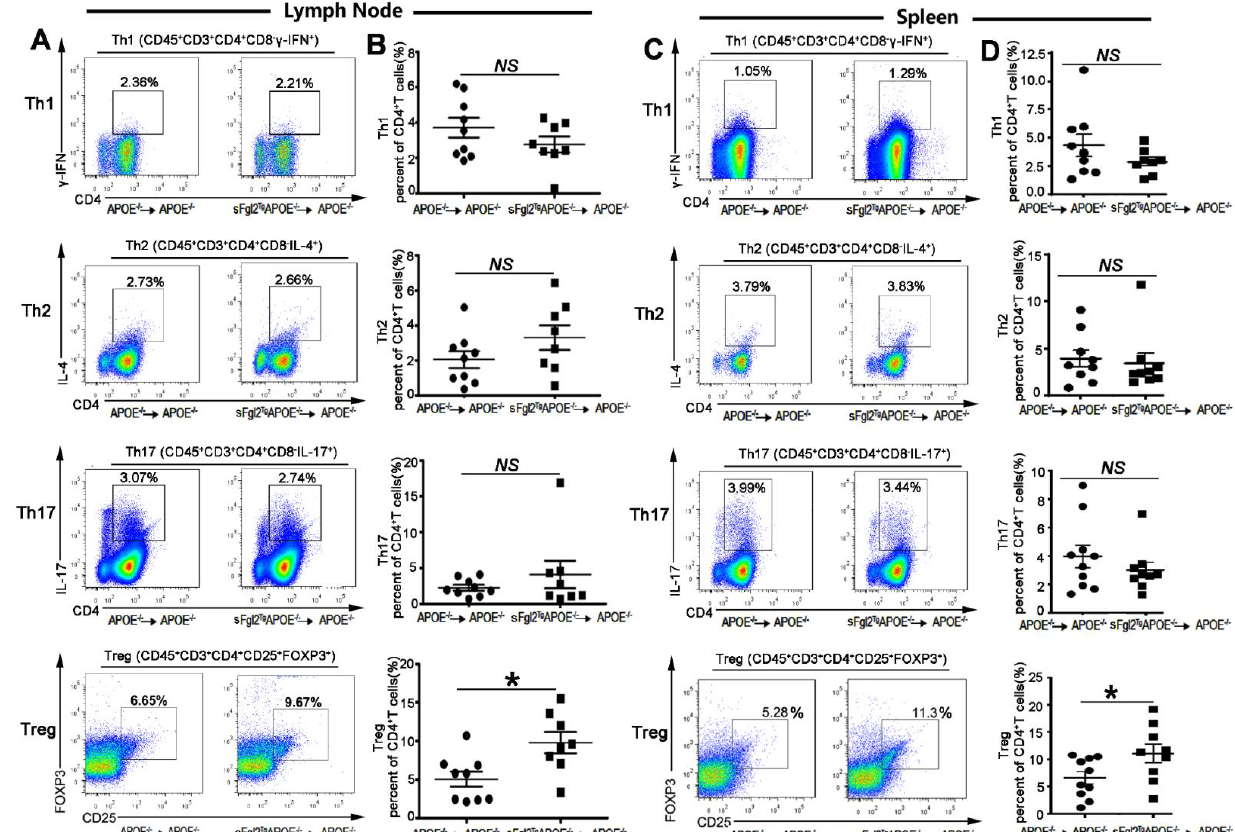
Figure 6. Over-expression of bone-marrow-derived sFgl2 increased Treg differentiation without affecting the population of T helper cells. ( A ) Representative flow cytometry analysis of Th1 (CD45 + CD3 + CD8 - CD4 + IFN- γ + ), Th2 (CD45 + CD3 + CD8 - CD4 + IL-4 + ), Th17 (CD45 + CD3 + CD8 - CD4 + IL- 17 + ), and Treg (CD45 + CD3 + CD4 + CD25 + Foxp3 + ) cells’ percent among CD4 + T cells in spleen of irradiated ApoE -/- mice reconstituted with sFgl2 Tg ApoE -/- or ApoE -/- bone marrow. Numbers represented the percentage of Th1, Th2, Th17, and Treg cells in CD4 + T cells. ( B ) Quantification results of ( A ). ( C ) FCM analysis of Th1, Th2, Th17, and Treg cells percent among CD4 + T cells in lymph nodes of irradiated ApoE -/- mice reconstituted with sFgl2 Tg ApoE -/- or ApoE -/- bone marrow. ( D ) Quantification results of ( C ). NS = Not significant, * p < 0.05. Data were represented as mean ±